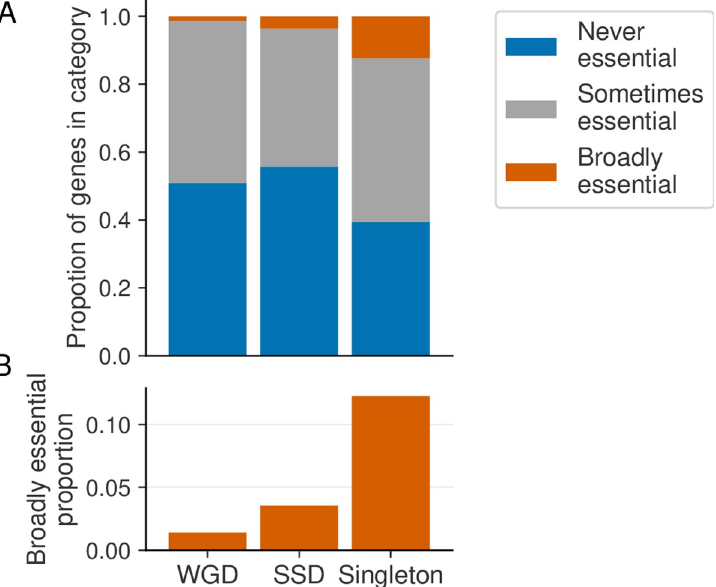
Fig 4. WGDs are more variably essential than SSDs. (A) Stacked bar graph showing the proportions of WGDs, SSDs and singletons that are never, sometimes and broadly essential. (B) Bar graph showing the proportion of WGDs, SSDs and singletons that are broadly essential (zoomed in version of the orange portion in